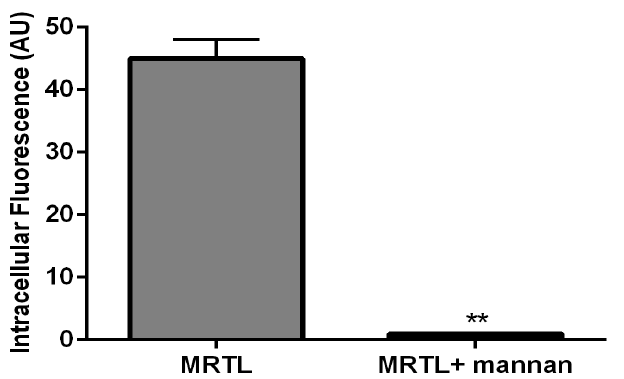
Figure 6. A natural MR ligand, mannan, inhibited the uptake of the FITC-labeled bivalent MRTL by